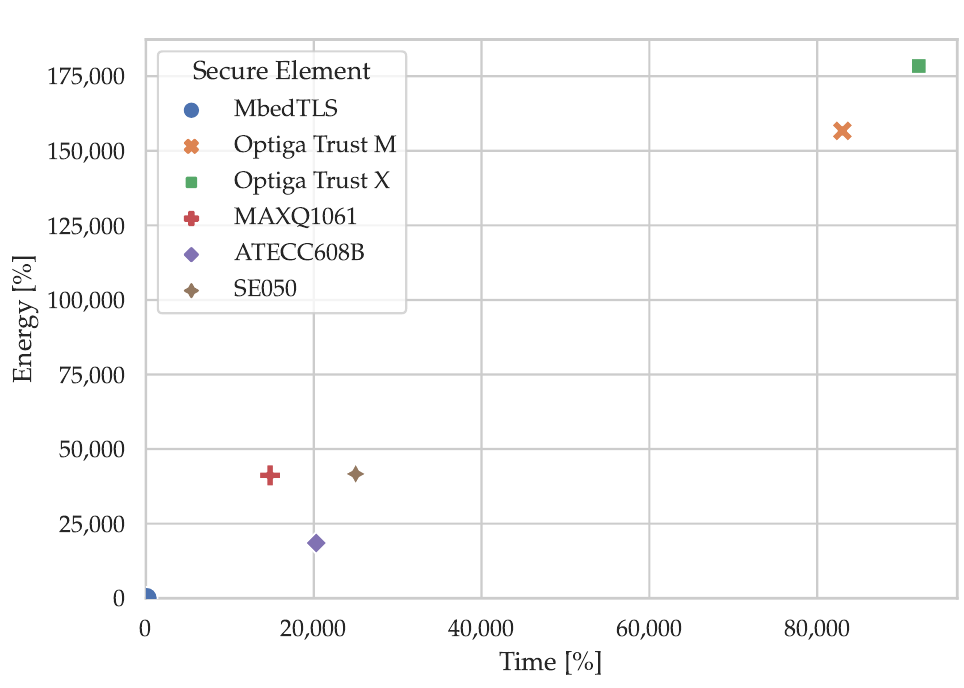
Figure 9. Time and energy measured for calculating the SHA-256 for 32 bytes of data relative to the reference implementation. (median of values, rounded to the nearest percent, n = 100). Table 3. Table of values for Figure